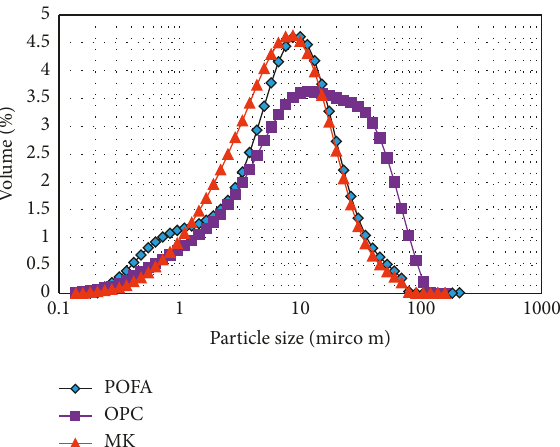
Figure 2: Particle size analysis of OPC, POFA, and MK (Mastersizer 2000 Ver 5.4, Malvern Instruments Ltd).